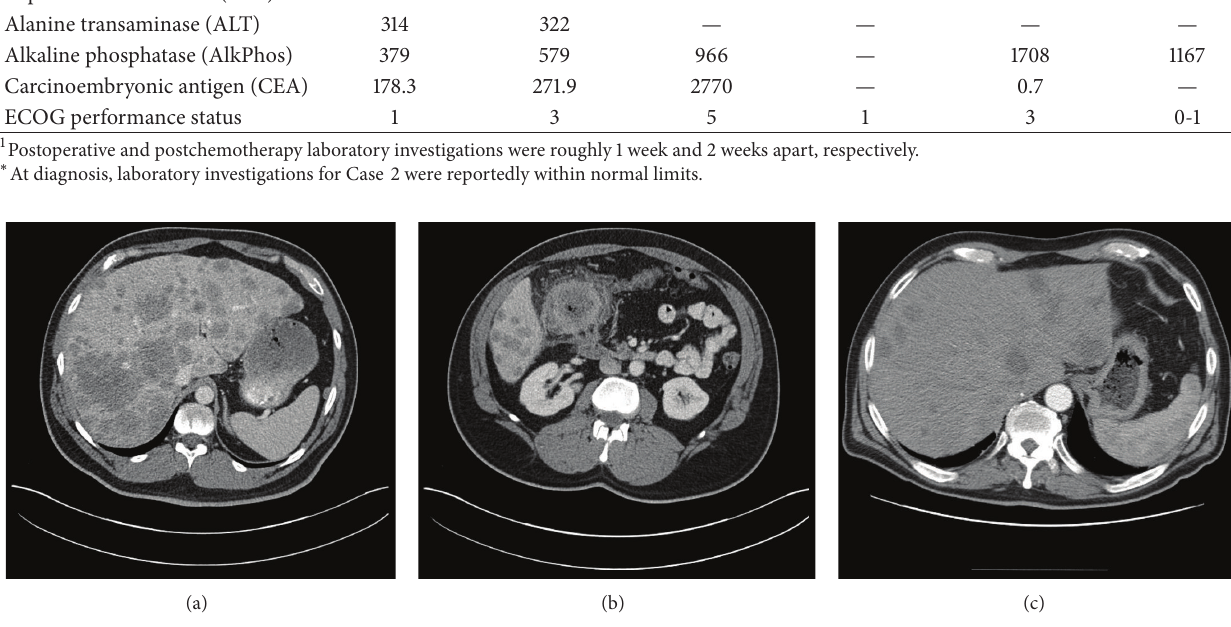
ECOG PS now had declined to 3 from 1 earlier.